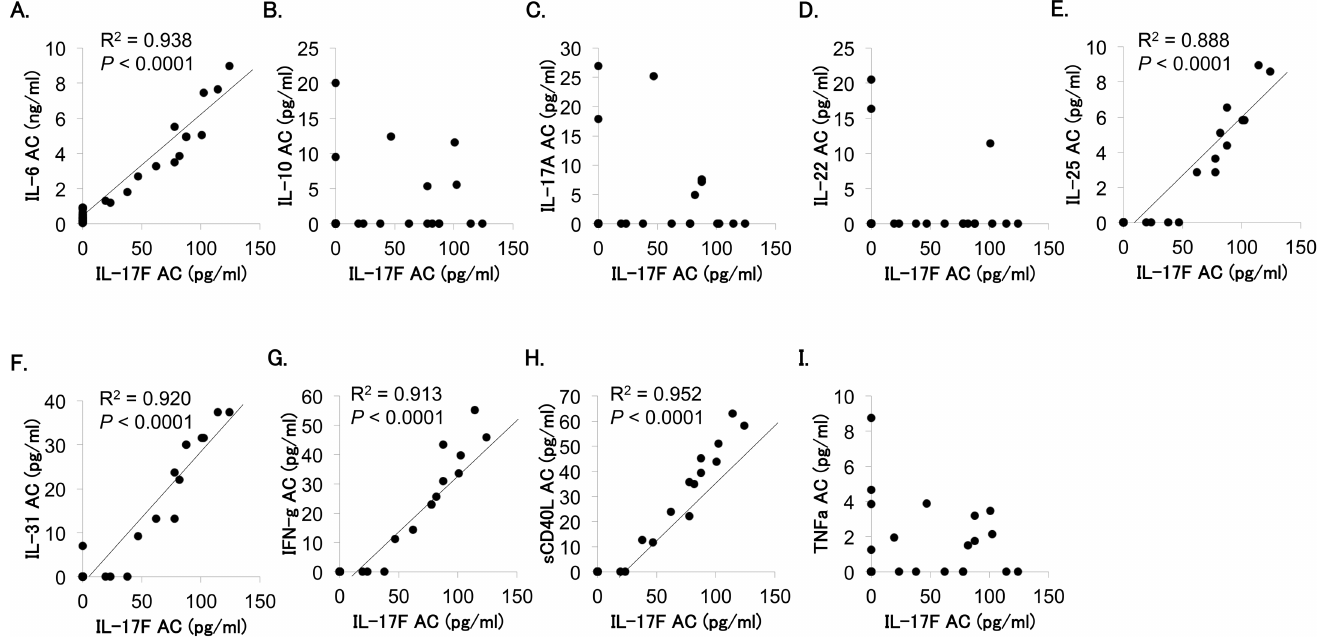
Fig 3. Association of IL-17F level with levels of other cytokines in aqueous humor of patients with proliferative diabetic retinopathy. Correlation of aqueous(AC) IL-17F level (x-axis) vs. aqueouslevels of other cytokines (y-axis) was analyzedby Spearman’s correlationcoefficient test. (A) IL-6: y = 306.1 + 57.7x, R 2 = 0.938, P < 0.0001; (B) IL-10: y = 1.74 + 0.010x, R 2 = 0.008, P = 0.6338; (C) IL-17A: y = 2.98–0.003x, R 2 = 0.0002, P = 0.9347; (D) IL-22: y = 1.84–0.008x, R 2 = 0.005, P = 0.6964; (E) IL-25: y = -0.32 + 0.06x, R 2 = 0.888, P < 0.0001; (F) IL-31: y = -0.82 + 0.30x, R 2